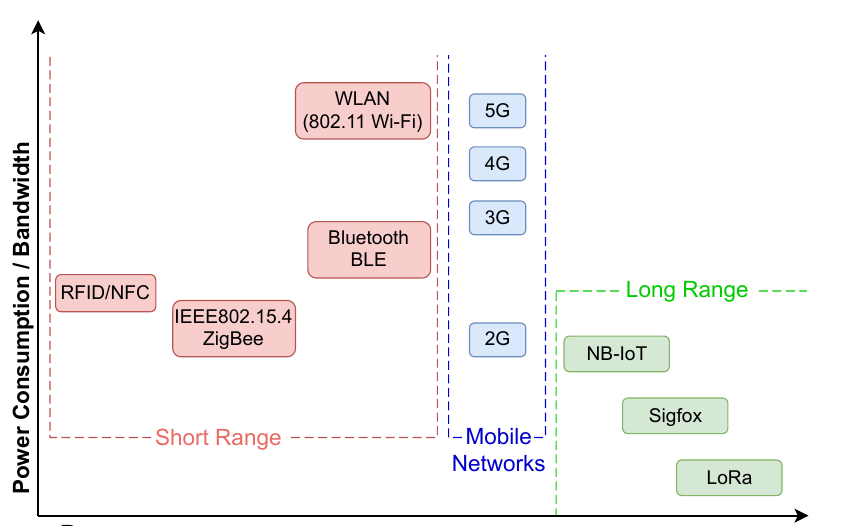
Figure 2. Power/Bandwidth vs. Range in wireless communication Technologies. Adapted from